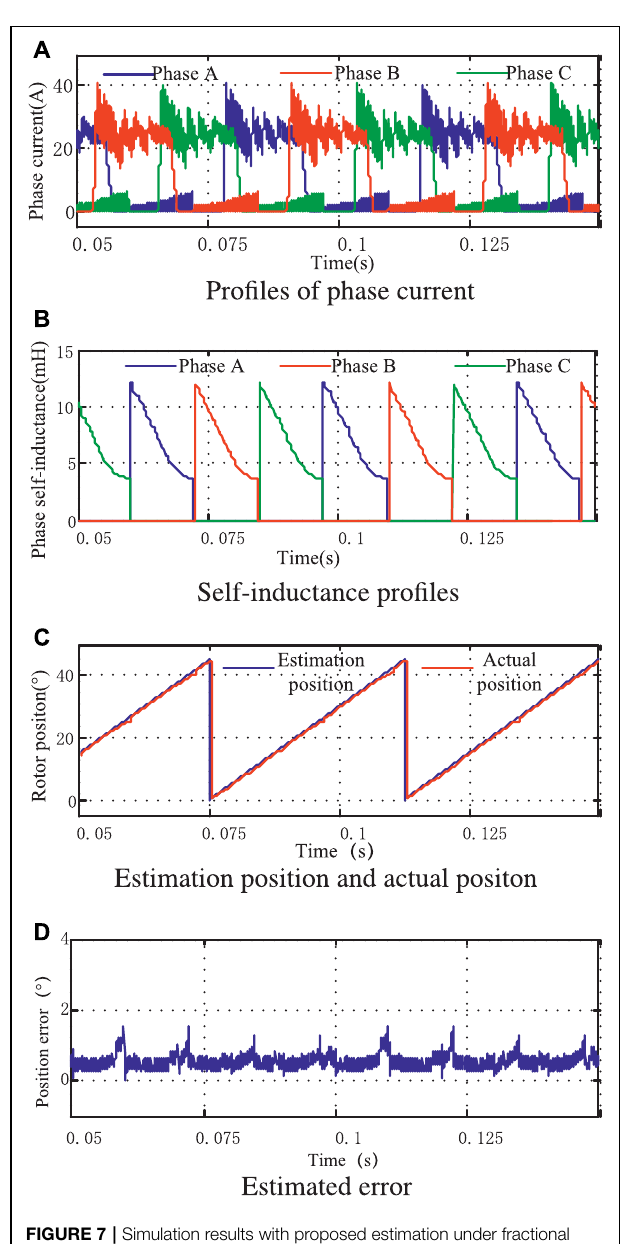
FIGURE 7 | Simulation results with proposed estimation under fractional load. (A) Profiles of phase current. (B) Phase inductance profile. (C) Estimation position and actual position. (D) Estimated error.